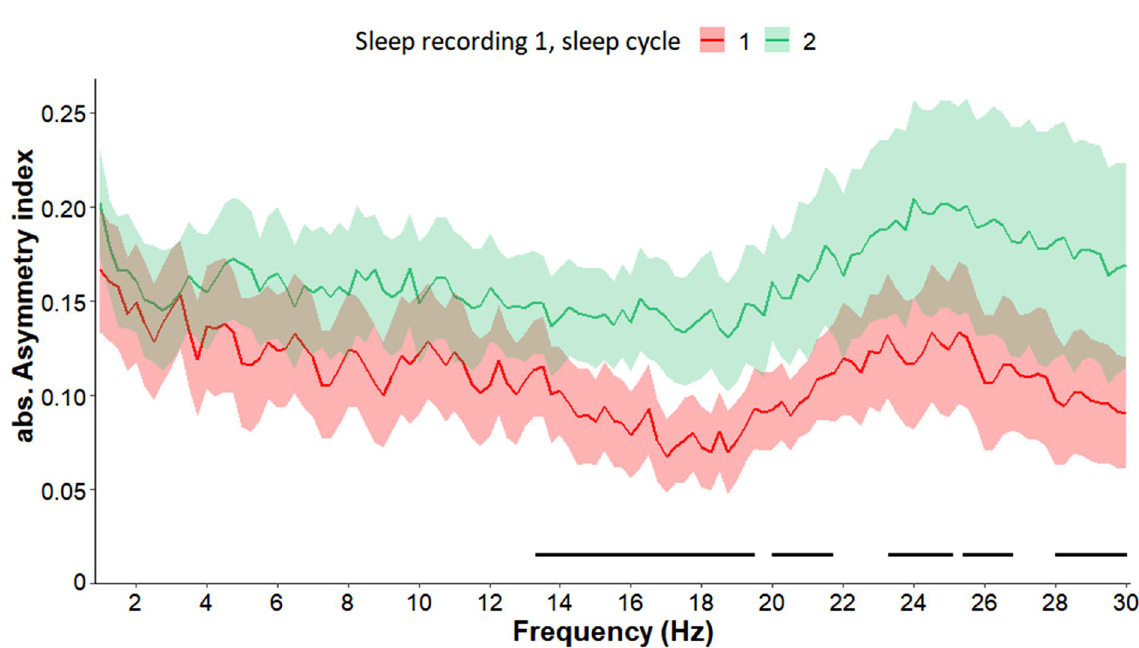
Figure 6. Absolute asymmetry index values (Mean + / − SE) in frequency range 1–30 Hz in the first and second sleep cycle of sleep recording 1. In the second sleep cycle greater asymmetry was observed in the frequency ranges of 13.5–19.5, 20–21.75, 23.5–25, 25.5–26.75 and 28–30 Hz, compared to the first sleep cycle. Frequency bins below the statistical threshold (all p s < 0.05, fulfilling the criteria of a significant Rüger area) are illustrated by a black horizontal